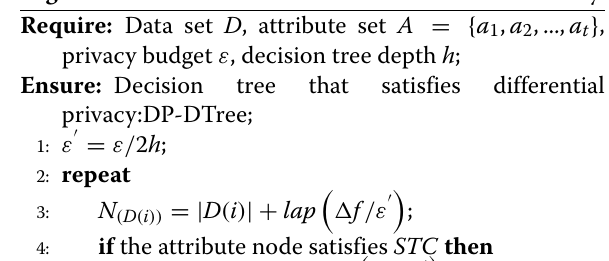
Algorithm 1 Decision Tree Based on Differential